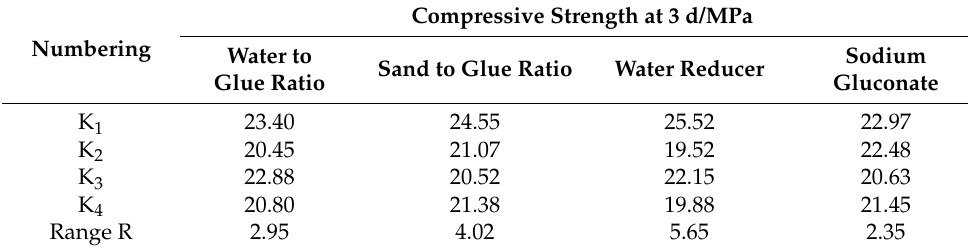
Table 10. Influence of various factors on the compressive strength at 3 d.